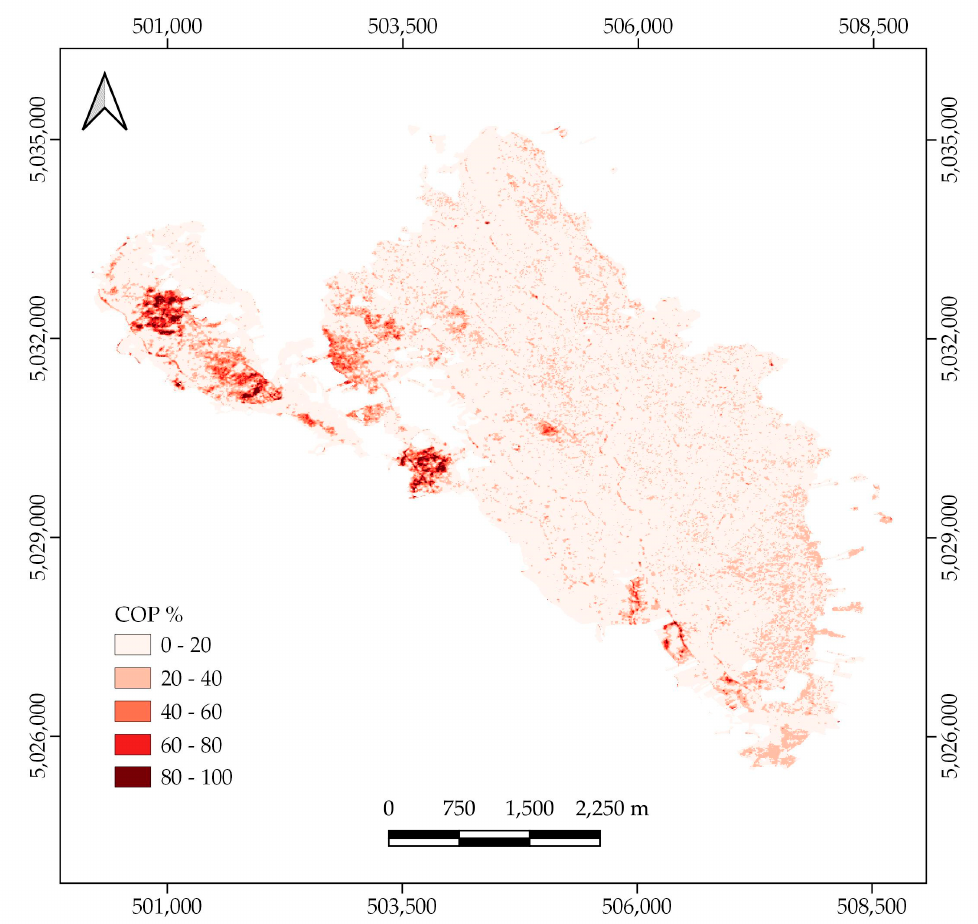
Figure 5. The final map of canopy openings percentage for FMU